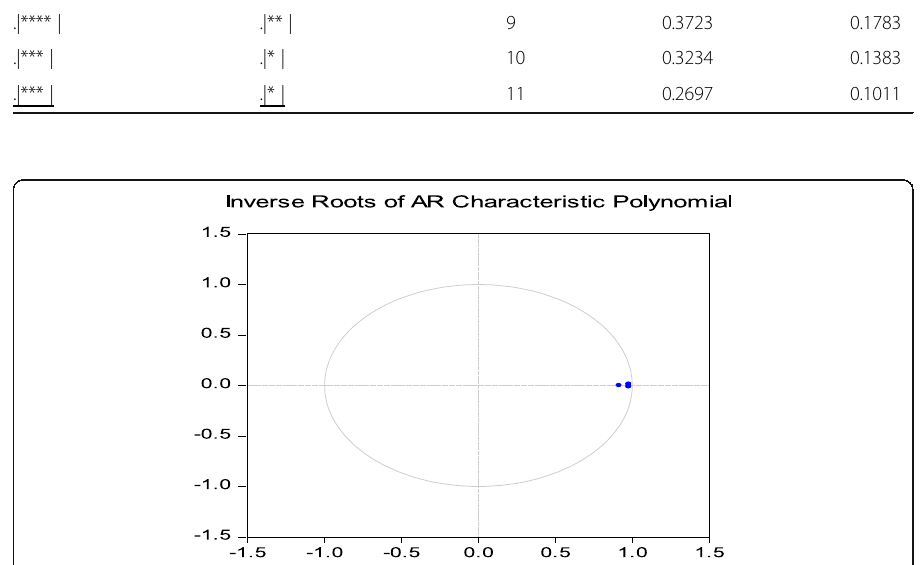
Fig. 2 Panel VAR causality Lag Selection Stability